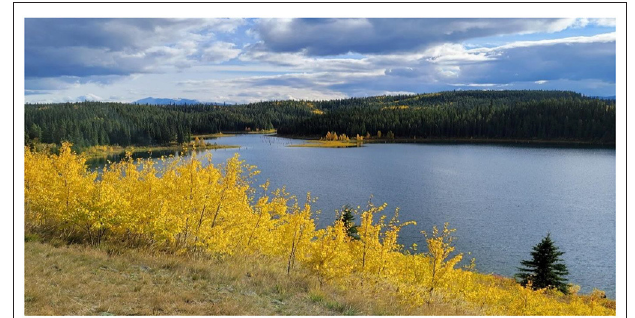
FIGURE 1 | Yukon, Fall